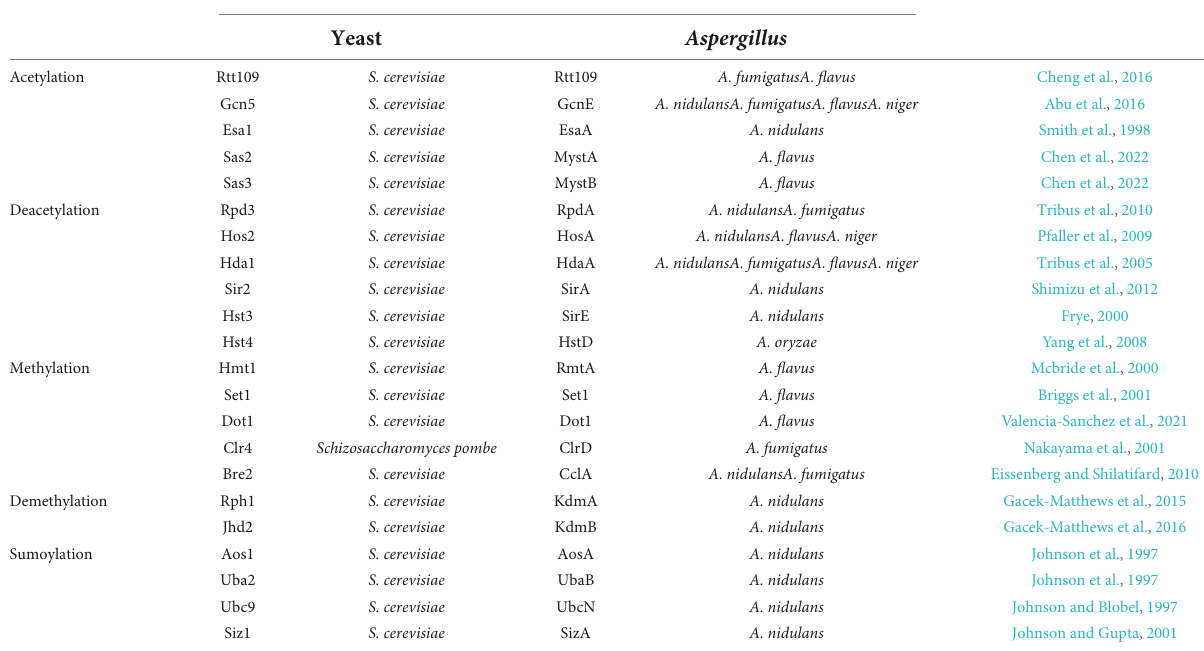
TABLE 1 Histones post-translations modifications in yeast and